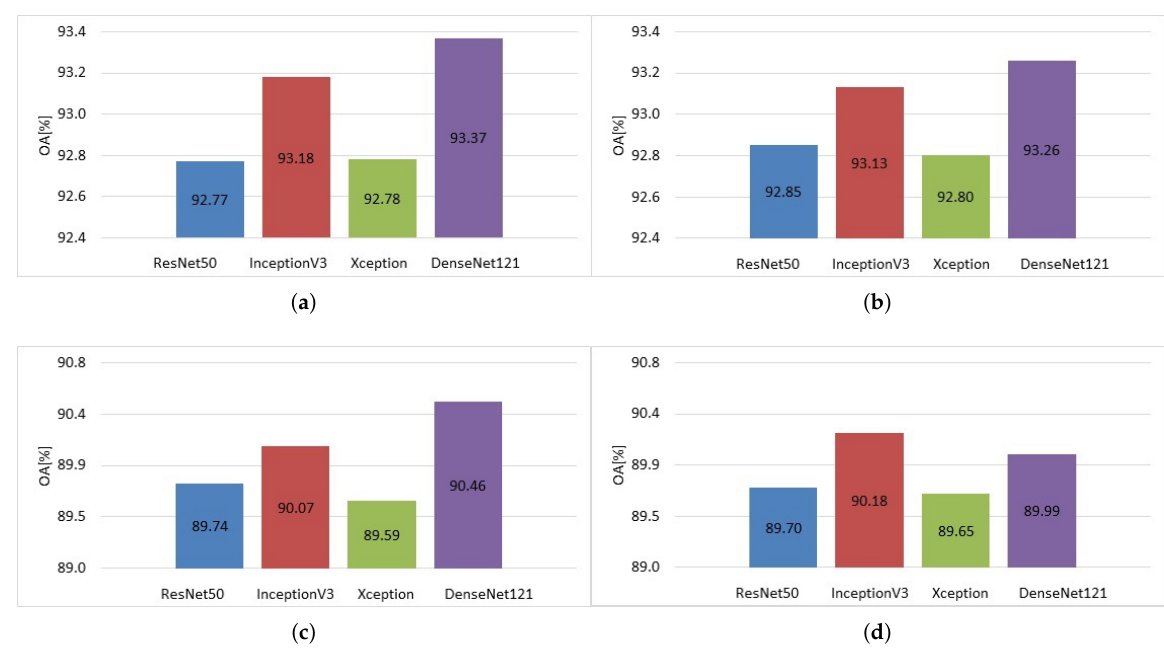
Figure 13. Overall Accuracy over five runs for NWPU-RESISC45 data set with linear SVM classifier and ( a ) 20%/80% train/test split ratio, linear decay scheduler; ( b ) 20%0% train/test split ratio, cyclical learning rates; ( c ) 10%/90% train/test split ratio, linear decay scheduler; ( d ) 10%/90% train/test split ratio, cyclical learning